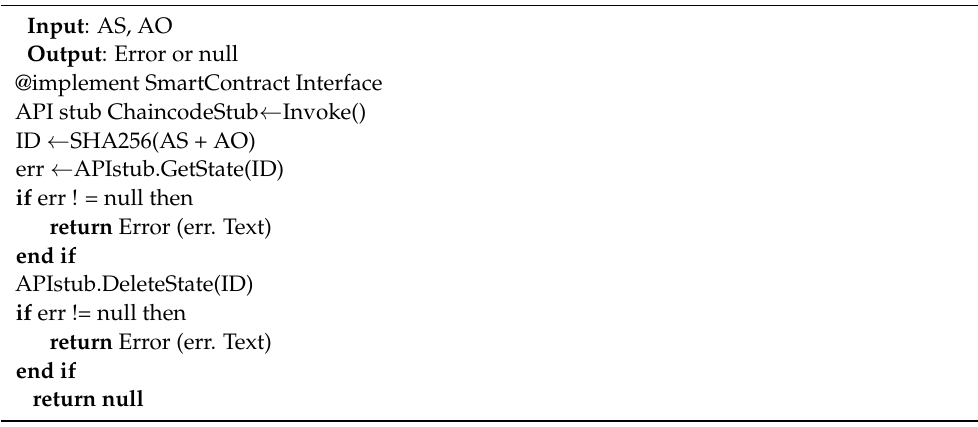
Algorithm 3: Delete ABAC Policy form blockchain